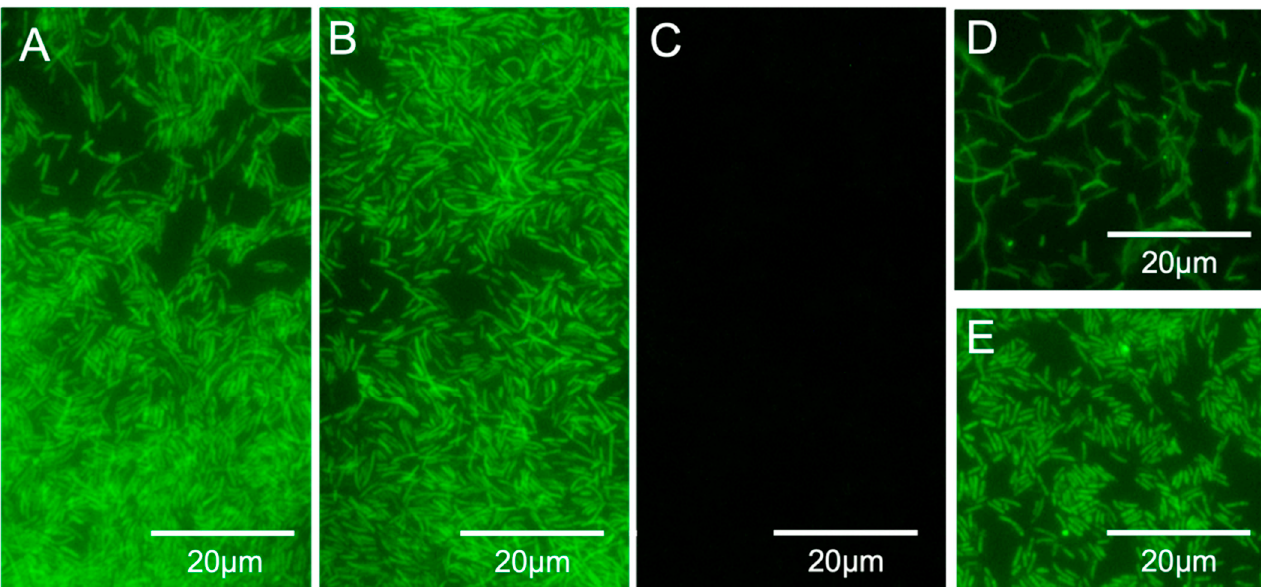
Figure 4. ( A – C ) PNA-FISH specificity and sensitivity results for the LEG22 peptide nucleic acid probe. ( A ) Legionella pneumophila serogroup 1, WDCM 00107; ( B ) Legionella anisa, ATCC 35292; ( C ) Escherichia coli (INSA isolate); ( D , E ) L. pneumophila serogroup 1, WDCM 00107 in filtered artificially contaminated water samples (10 8 CFU per sample). ( D ) PNA-FISH on the membranes; ( E ) PNA-FISH